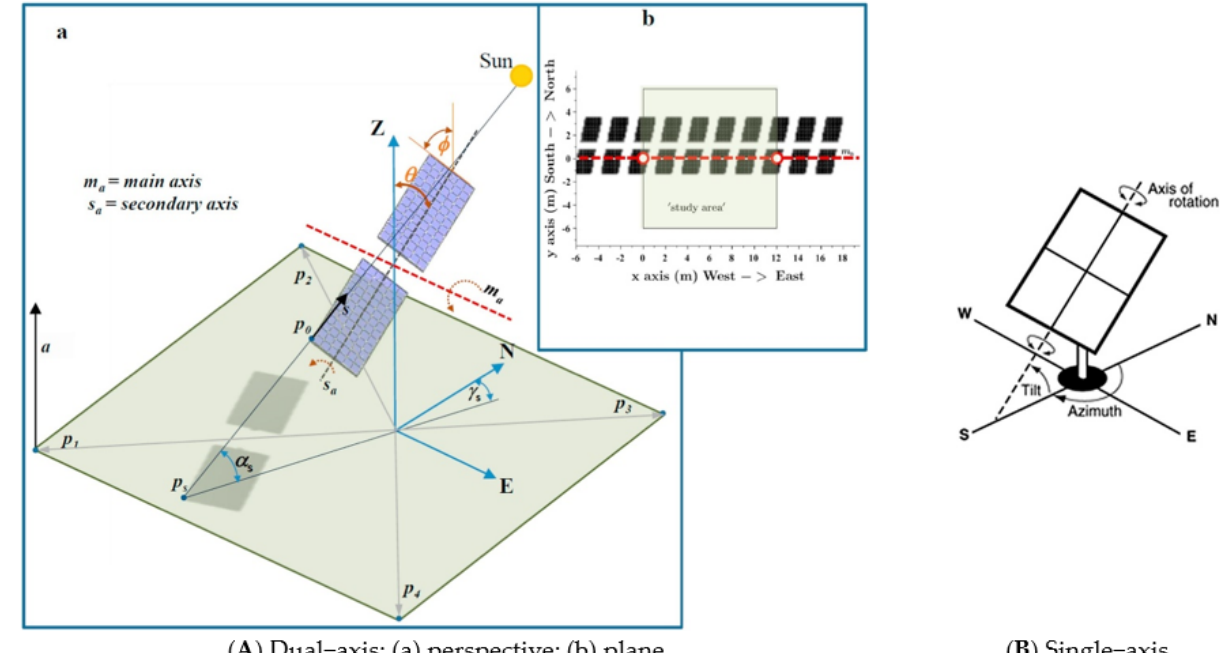
Figure 3. Different options for PV array tracking. ( A ) source: [26], ( B ) source: [37].